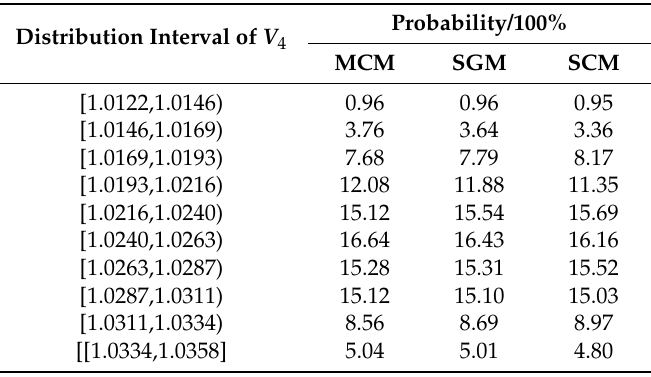
Table 5. The frequency table of different methods.